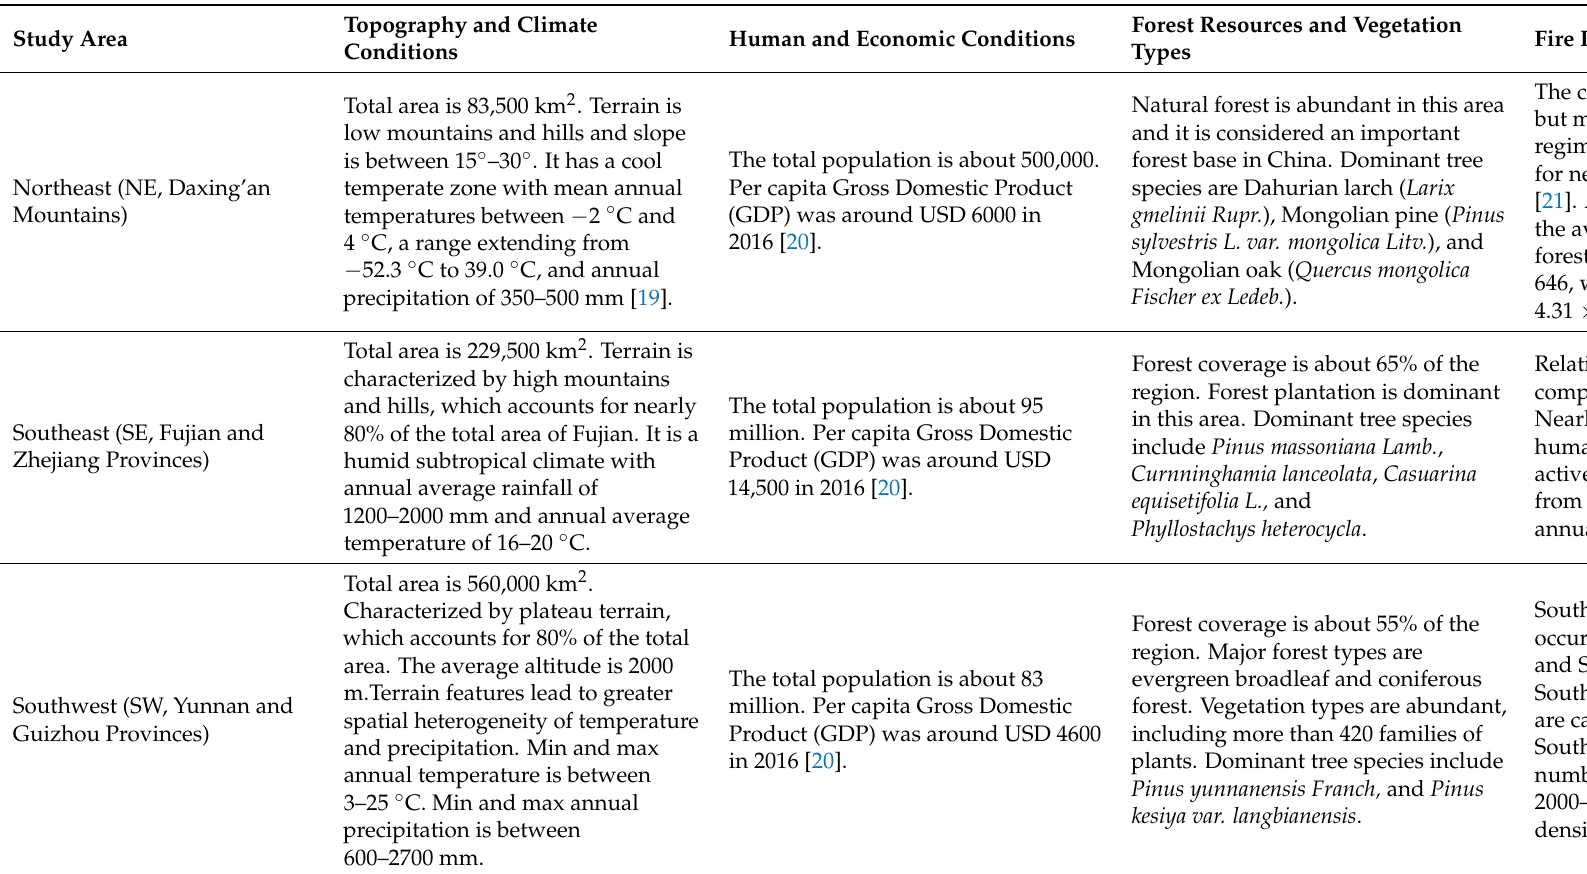
Table 1. Description of study